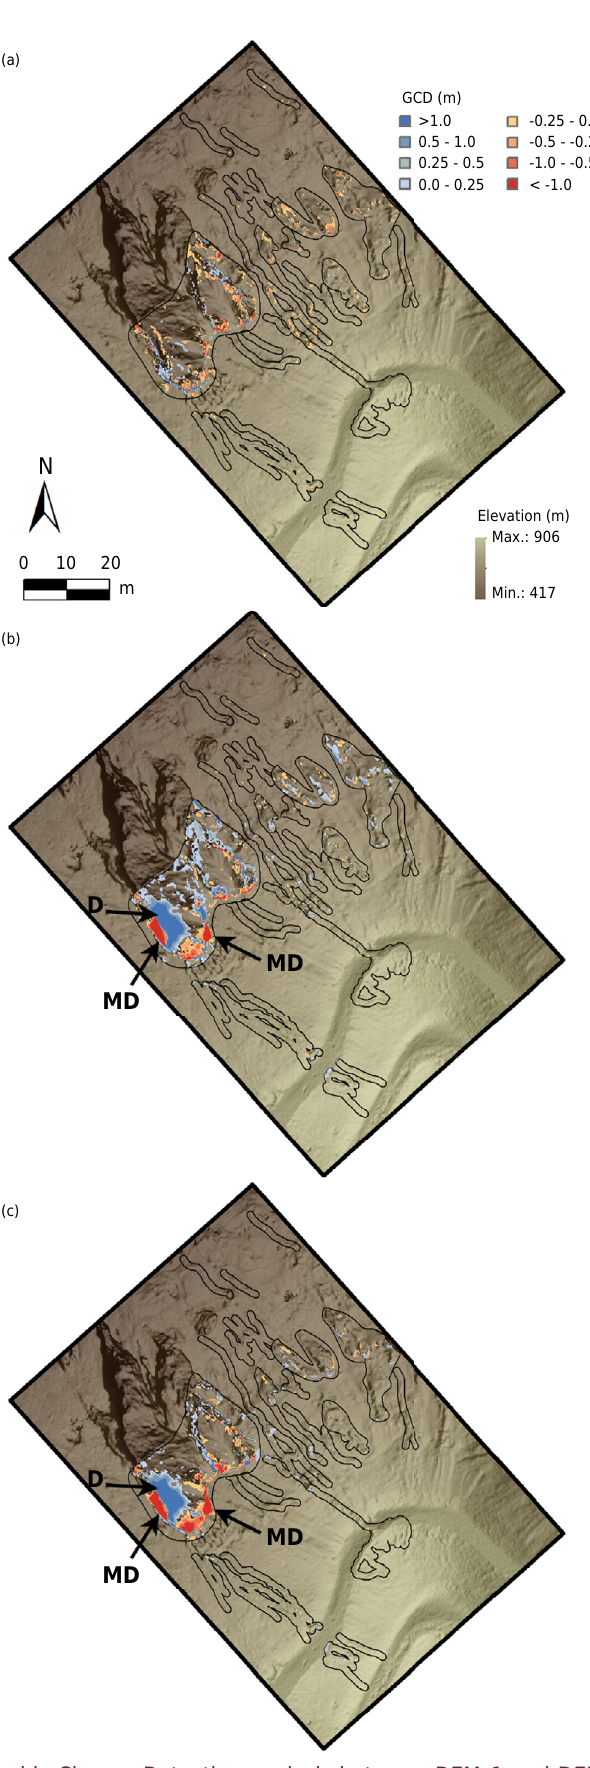
Figure 3. Geomorphic Change Detection analysis between DEM_1 and DEM_2 (a), DEM_1 and DEM_3 (b), and DEM_1 and DEM_4 (c). Arrows indicate mass displacement (MD, red areas) and deposition (D, blue